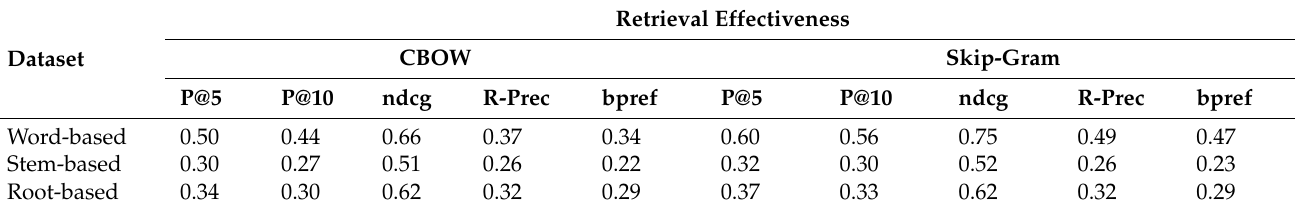
Table 9. Query expansion retrieval effectiveness using fastText.